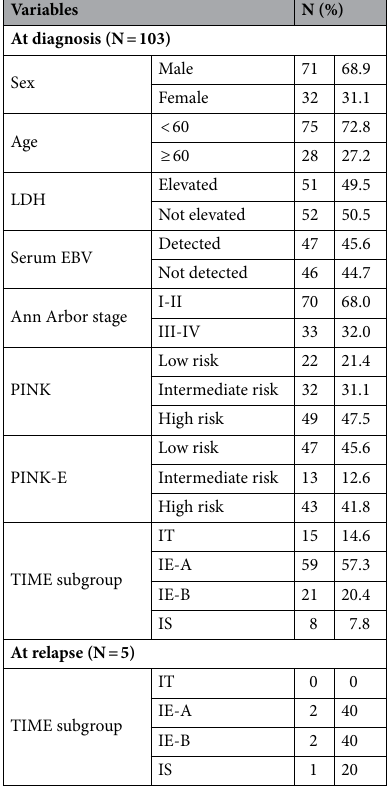
Table 1. Patient characteristics. LDH, lactate dehydrogenase; EBV, Epstein-Barr virus; LN, lymph node; PINK, prognostic index for extranodal NK/T-cell lymphoma; CTx, chemotherapy; RTx, radiotherapy; HSCT, hematopoietic stem cell transplantation; TIME, tumor immune microenvironment; IT, immune tolerance; IE, immune evasion; IS, immune